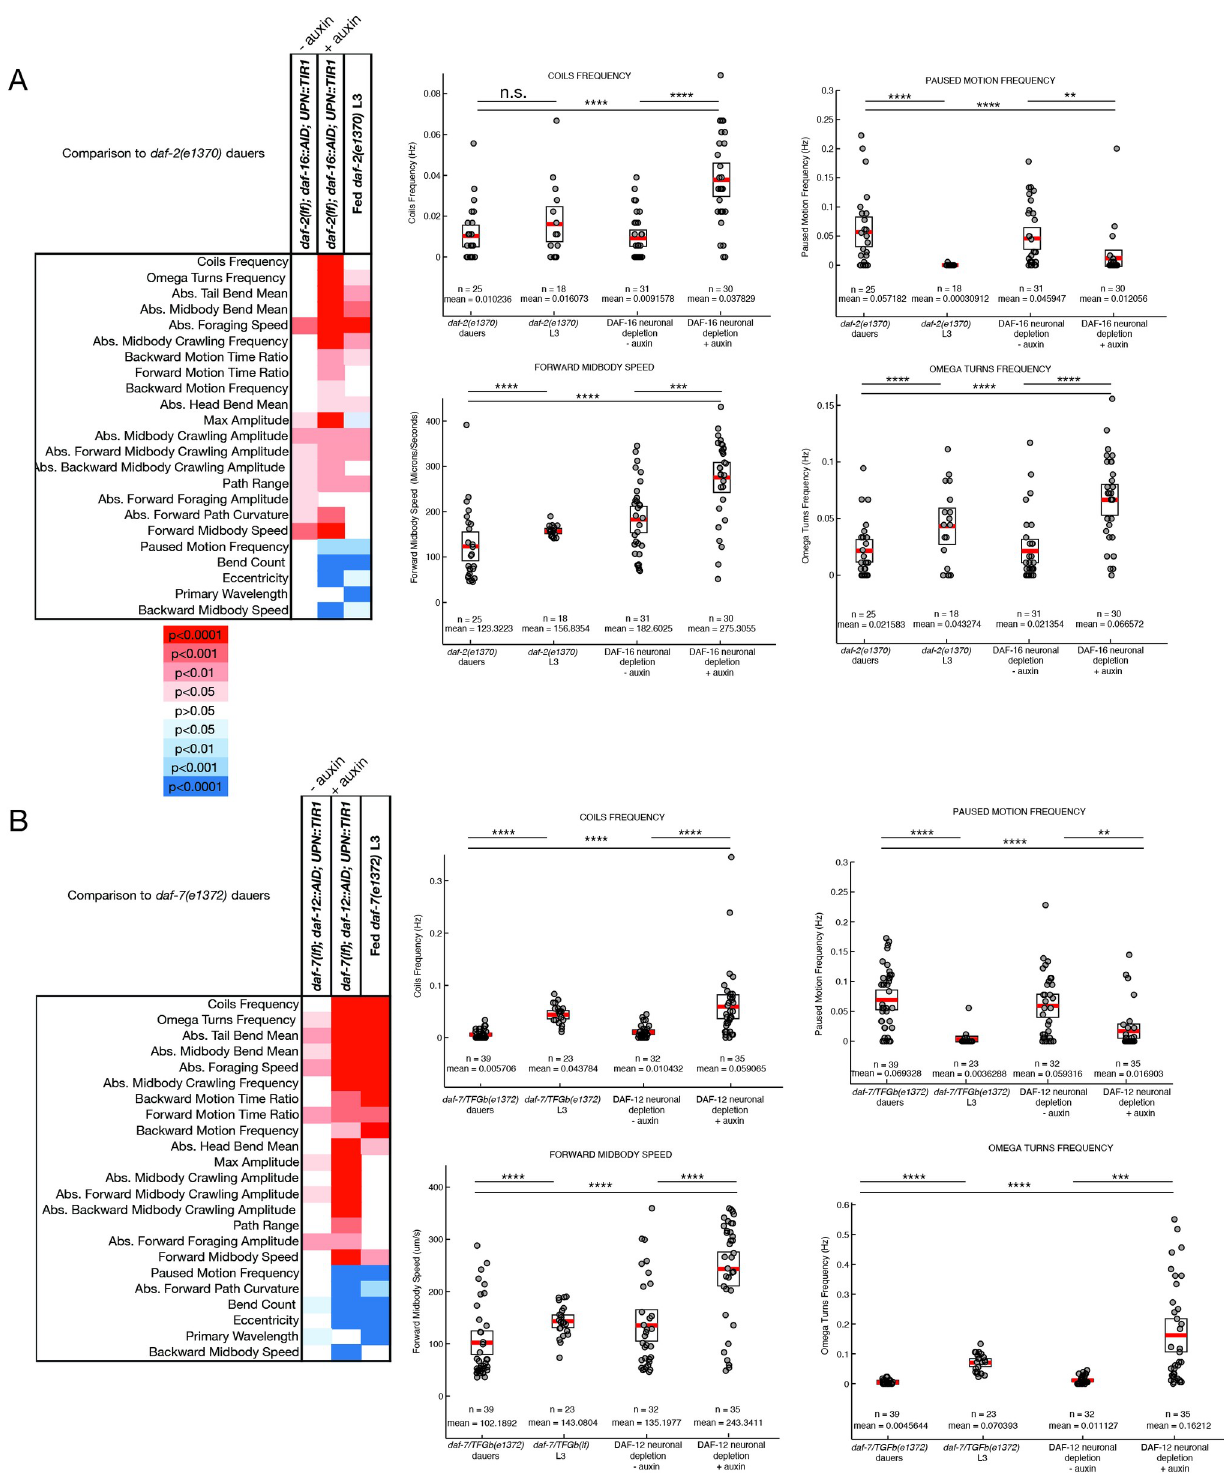
Fig 7. DAF-16/FoxO and DAF-12/VDR act in the nervous system to affect dauer-specific locomotory behavior. ( A ) A heat map of p -values associated with locomotory features of panneuronally DAF-16/FoxO-depleted dauers. ( B ) Representative locomotory features, which distinguish dauers with panneuronal depletion of DAF-16/FoxO from controls. ( C ) A heat map of p -values associated with locomotory features of panneuronally DAF-12/VDR- depleted dauers. ( D ) Representative locomotory features which distinguish dauers with panneuronal depletion of DAF-12/VDR from controls. Each circle